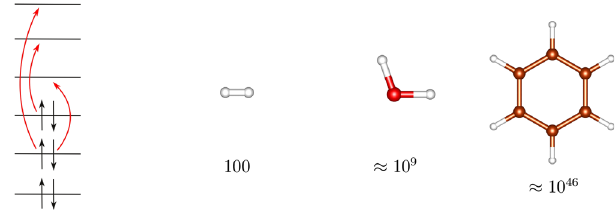
Fig. 1 Exponential scaling of FCI. Scheme of formation of all possible con fi gurations from the mean- fi eld solution and exponential scaling of the resulting full con fi guration interaction (FCI) method demonstrated on the examples of H 2 , H 2 O, and C 6 H 6 molecules. The numbers below the molecular structures represent the number of con fi gurations (Slater determinants) in the FCI wave function expansions in double- ζ basis.